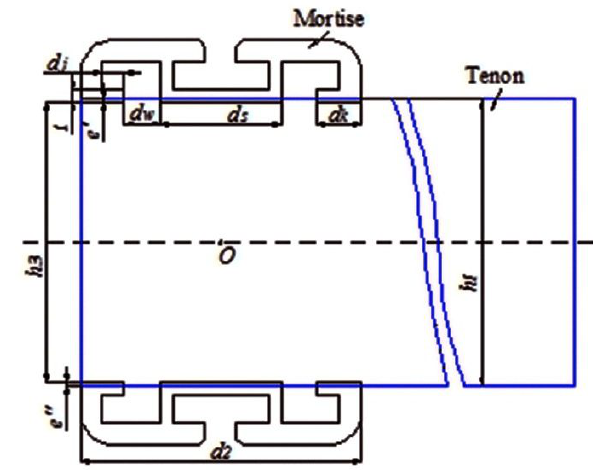
Figure 4: MT-T joint dimension